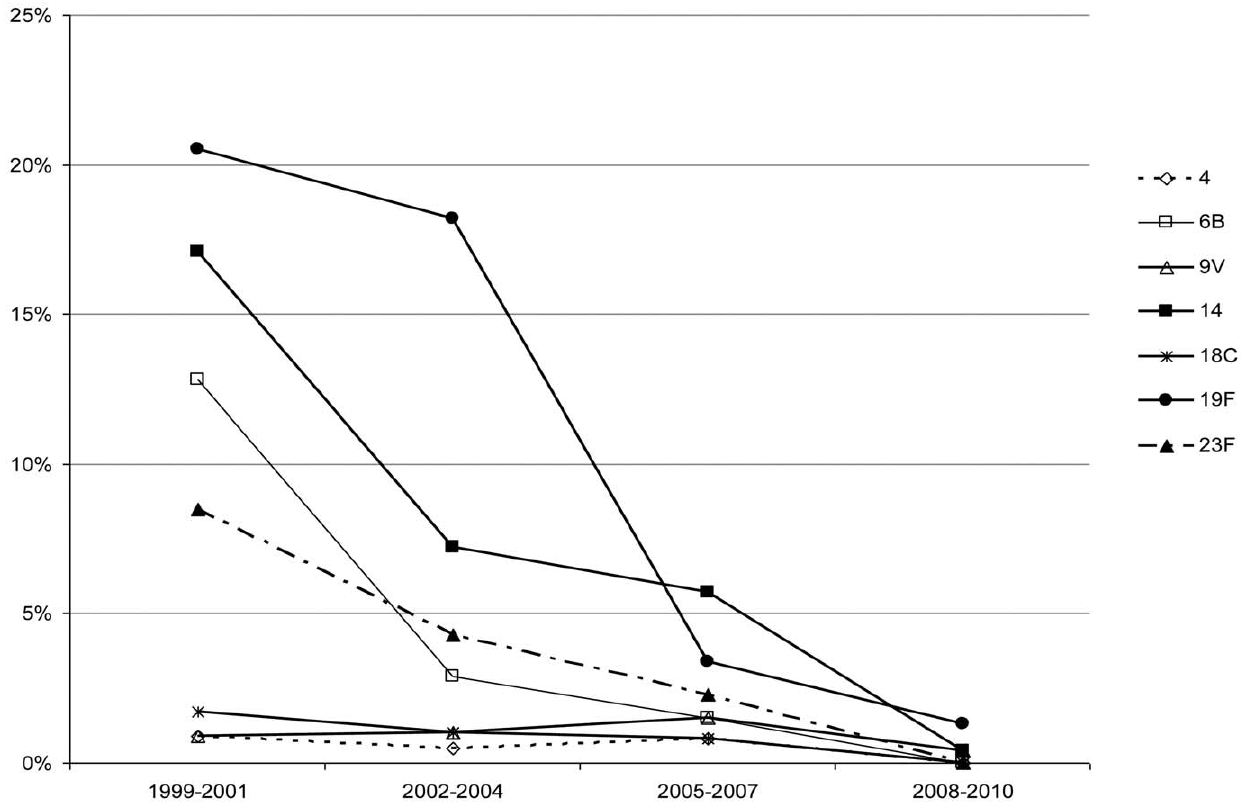
Figure 1. Percentage evolution of serotypes (number of a specific serotype/total isolates in each period) included in the 7-valent pneumococcal conjugate vaccine.